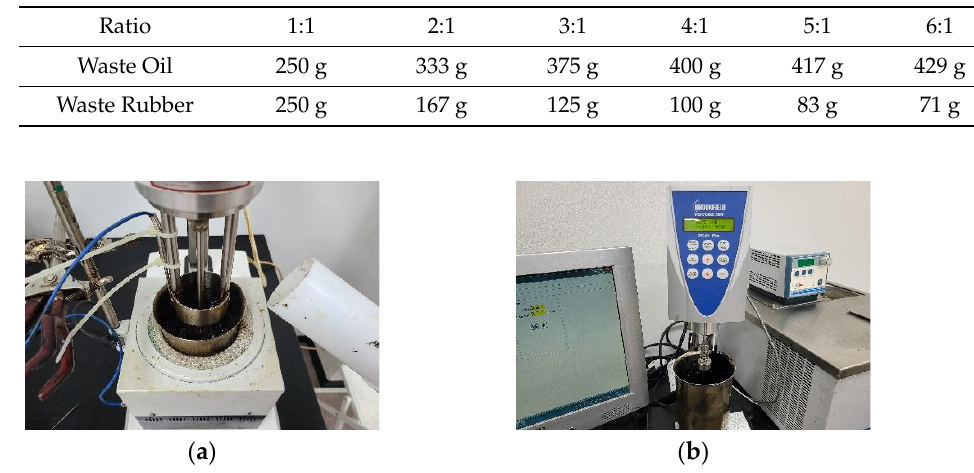
Figure 3. Mixture of waste oil and waste rubber and viscosity measurement. ( a ) Mixture between waste oil and waste rubber. ( b ) Measurement of viscosity of molten liquid agent.